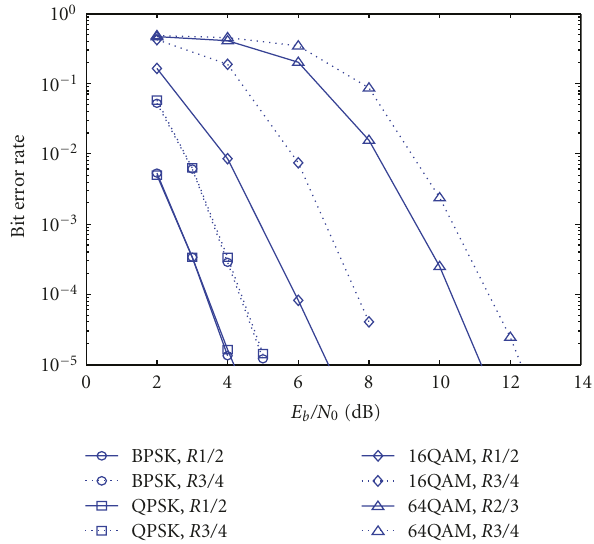
Figure 9: BER performance of IEEE802.11a and IEEE802.11p physical layers in AWGN channel environments.